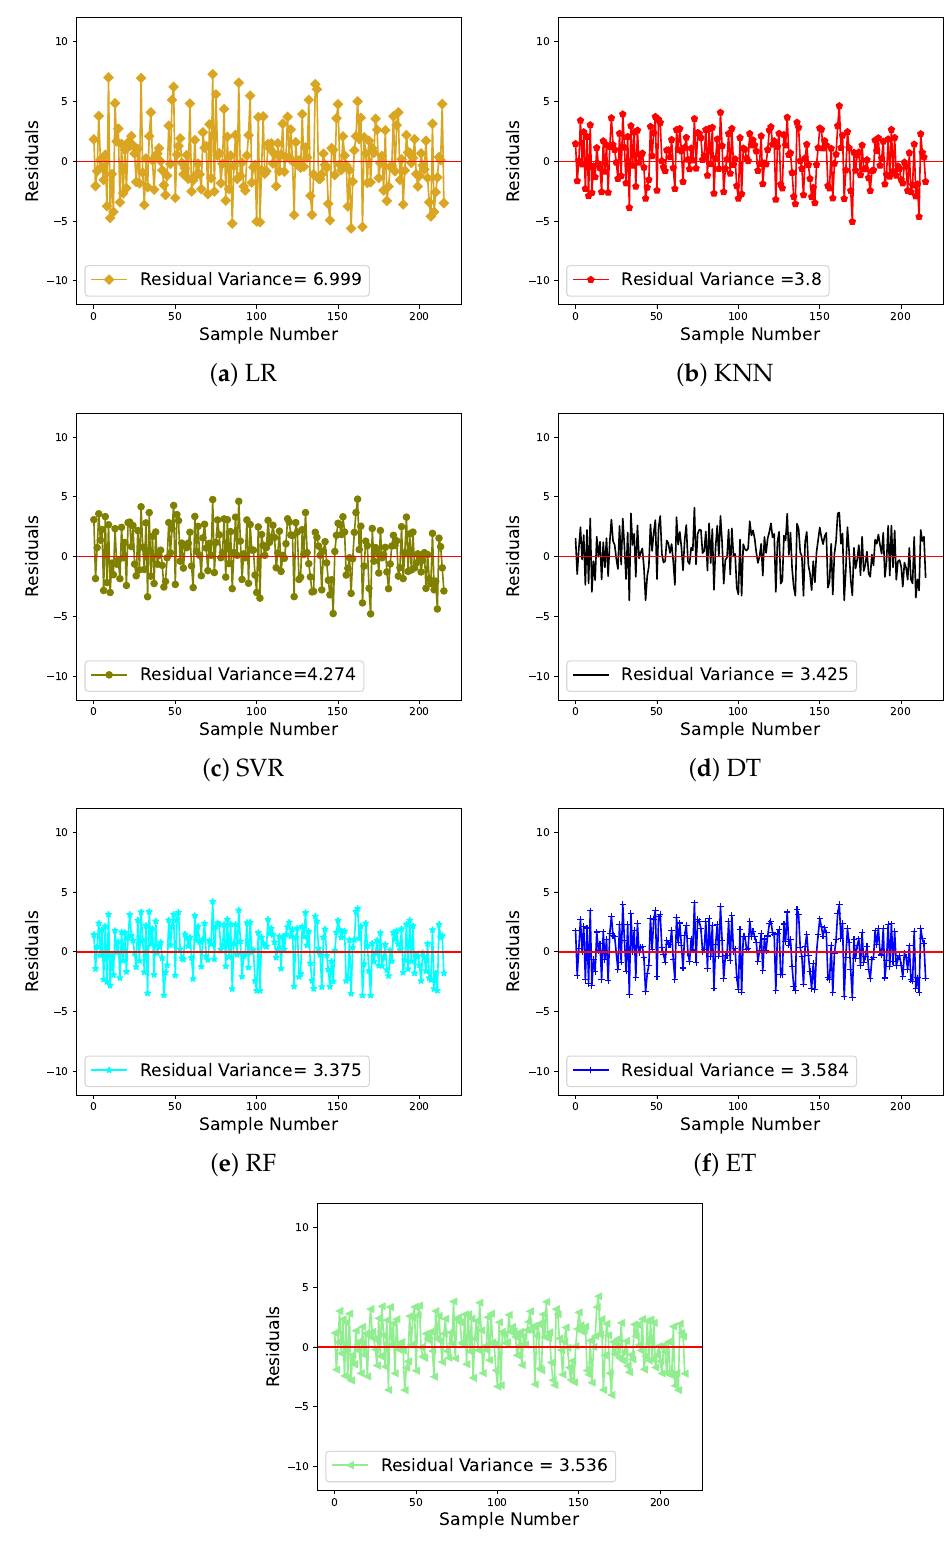
Figure 4. Fluctuations in errors, the model showing the least fluctuations represents the desirable